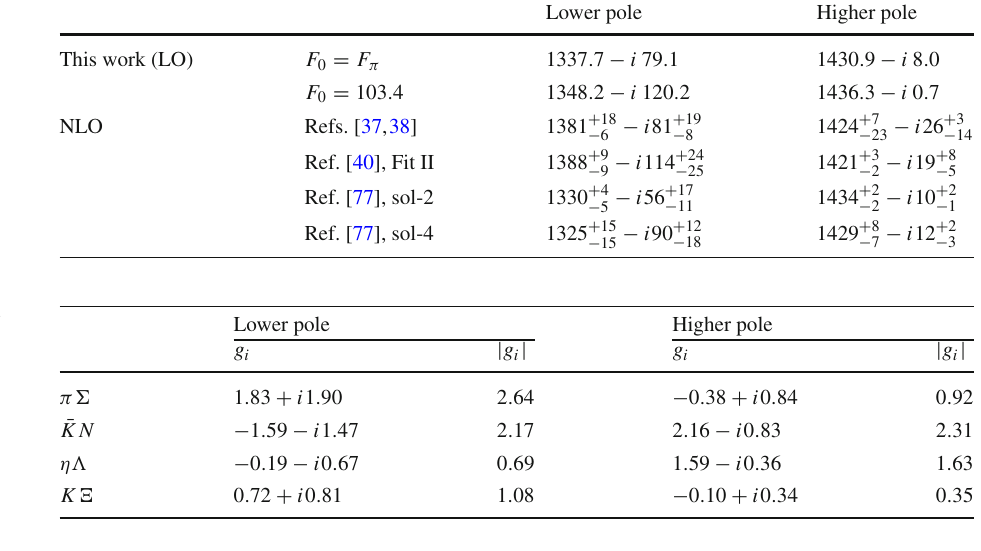
Table 4 Pole positions z R of (cid:2)( 1405 ) in the S = − 1 sector (units are MeV)